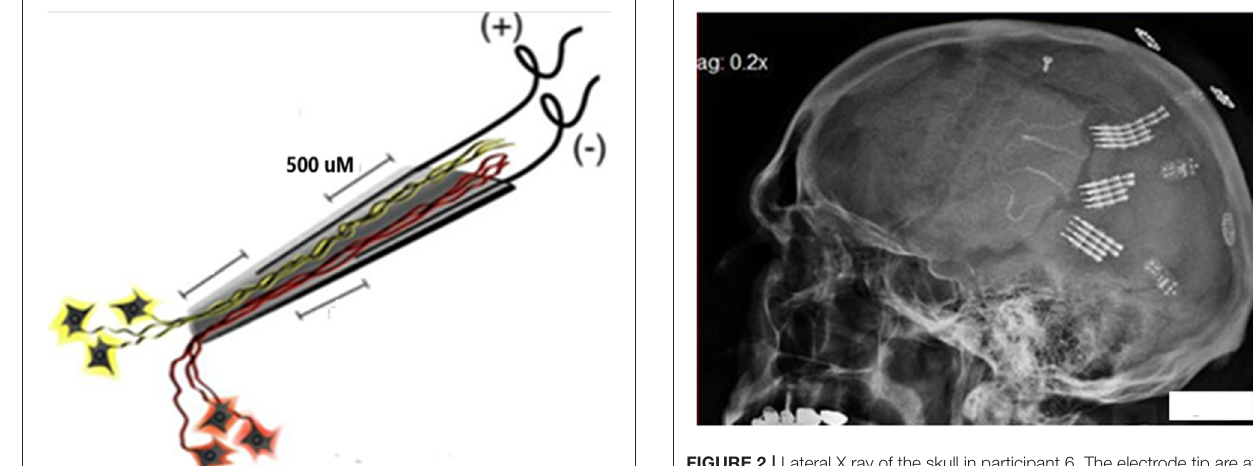
FIGURE 2 | Lateral X ray of the skull in participant 6. The electrode tip are at center, the connecting pins to the right of center, with amplifiers and finally the power induction coils (that appear to be floating). Three pairs of the eight pairs of electrodes wires are attached to three sets of connecting pins that are attached to three electronic amplifiers and FM